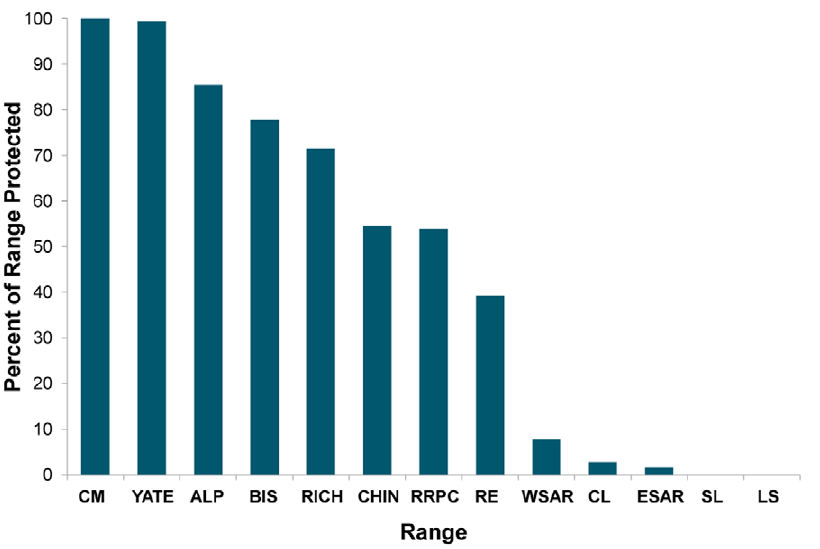
Figure 5. Percentage of each range protected in Scenario 2. The model included risk and cost and the overall caribou protection target was 50%.